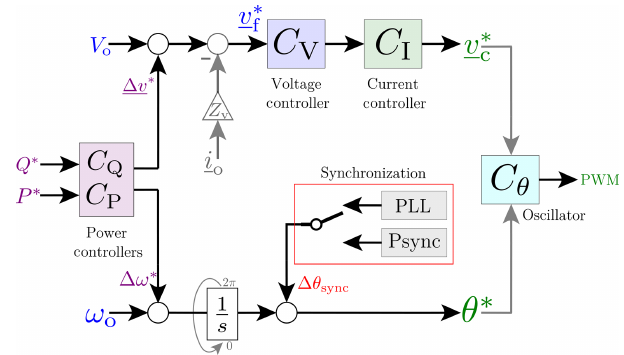
Figure 1. Grid-forming control structure consisting of current con- trol loop C I , the voltage controller C V , and outer real/reactive power control loops C P , Q